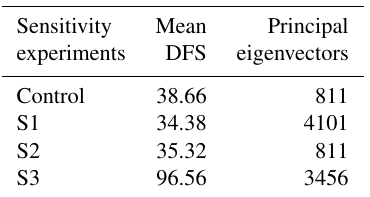
Table 6. Number of degrees of freedom for signal (DFS) in the prior flux uncertainty and the number the principal eigenvector in the prior error covariance matrix for sensitivity experiments S1, S2 and S3. Sensitivity Mean Principal experiments DFS